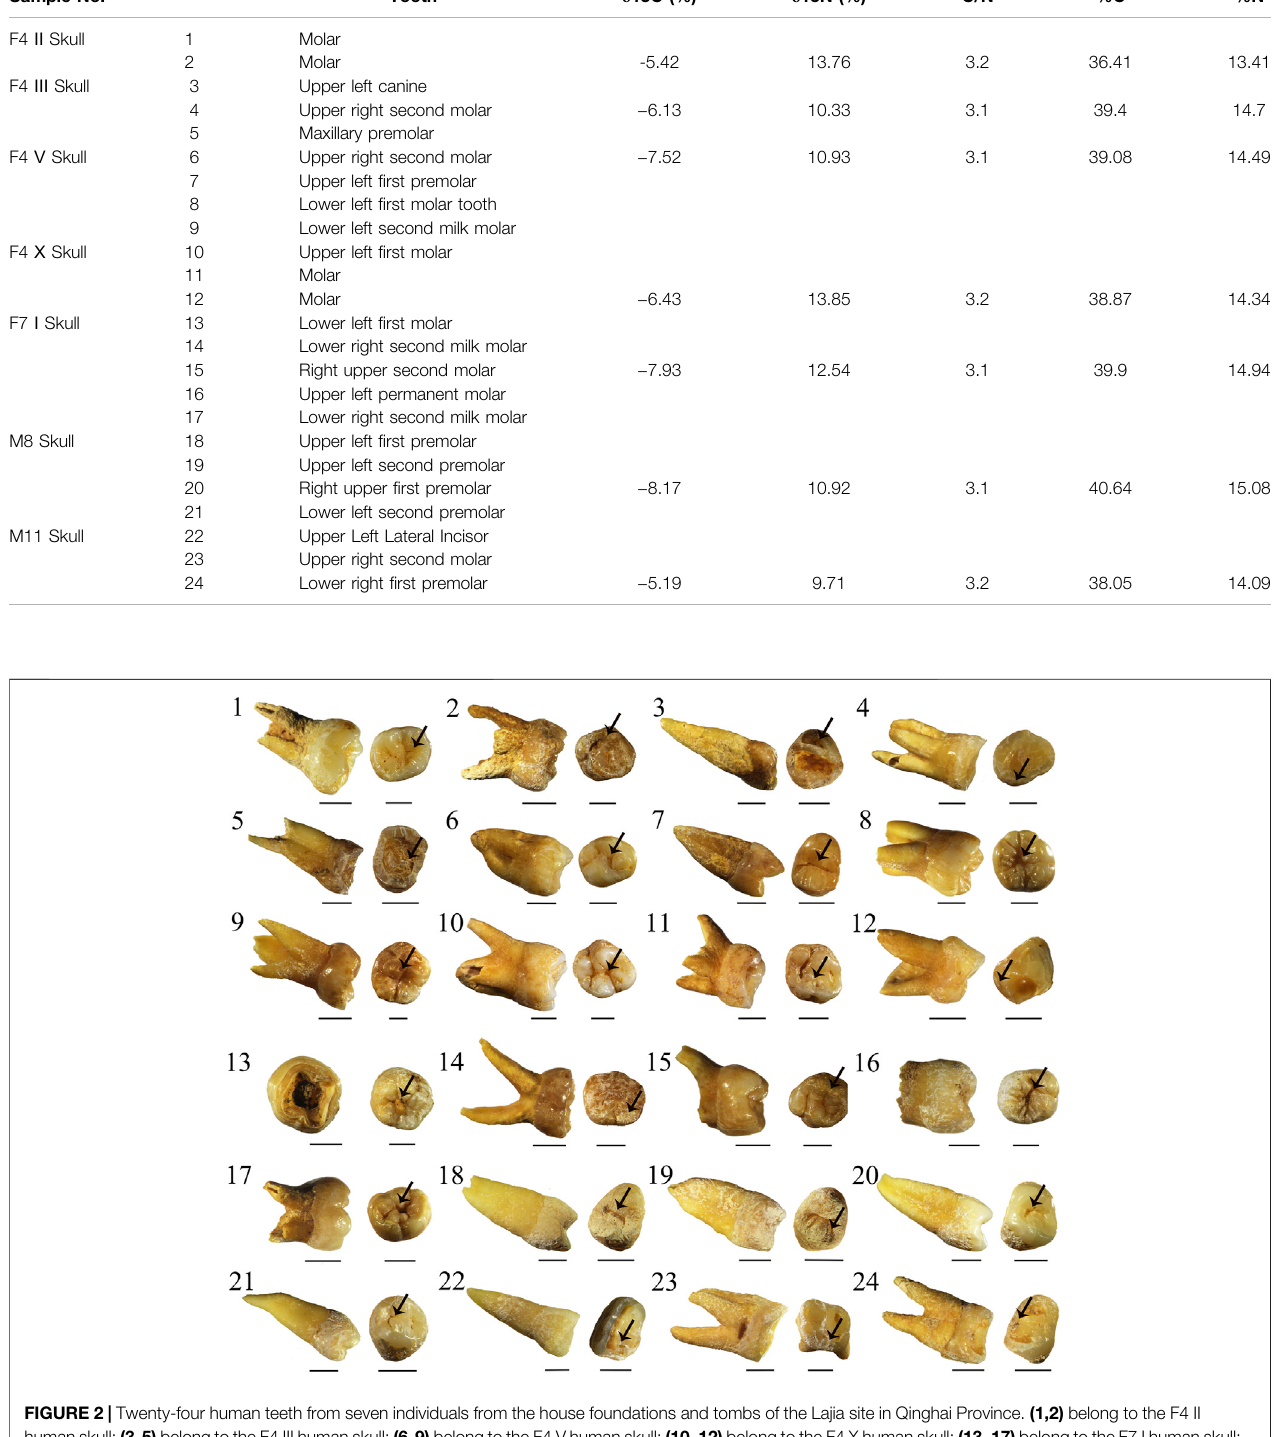
Frontiers in Earth Science |